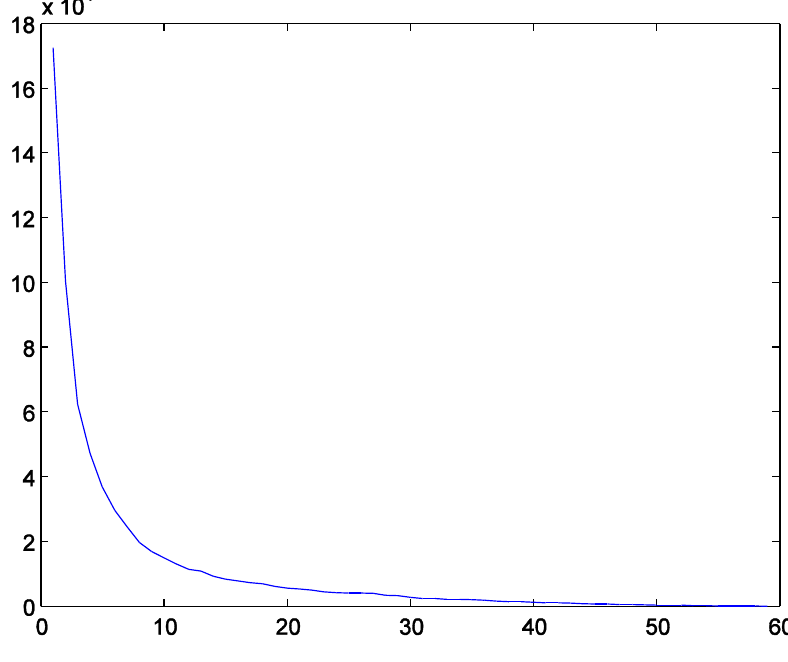
Figure 5. The value of objective Equation (2) with different numbers of